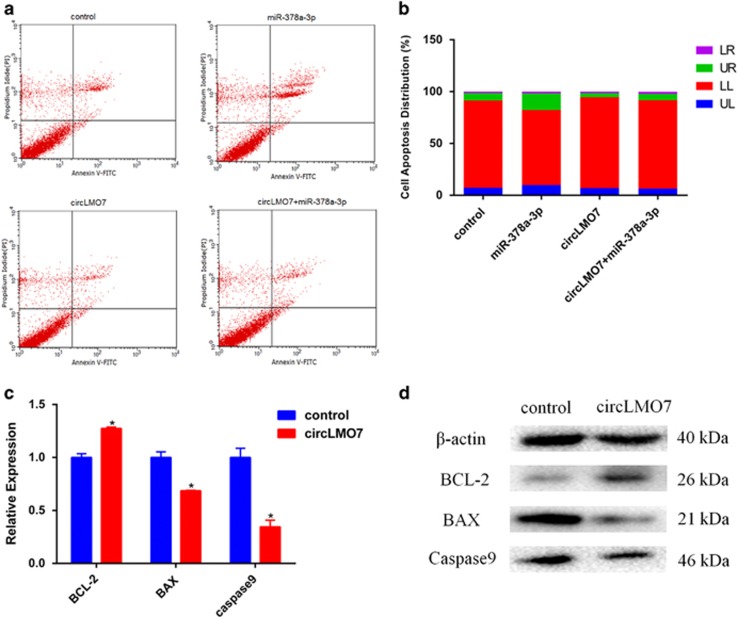
circLMO7 inhibits apoptosis in bovine primary myocytes. (a, b) We transfected bovine primary myocytes with pcDNA-circLMO7 and/or miR-378a-3p mimic and determined apoptosis by Annexin V-FITC/PI binding followed by flow cytometry. (c) mRNA of apoptosis marker genes (BCL-2, BAX, caspase9) was detected using qPCR. (d) Proteins of apoptosis marker genes were detected using western blots. Data are presented as means±S.E.M. for three individuals. *P<0.05